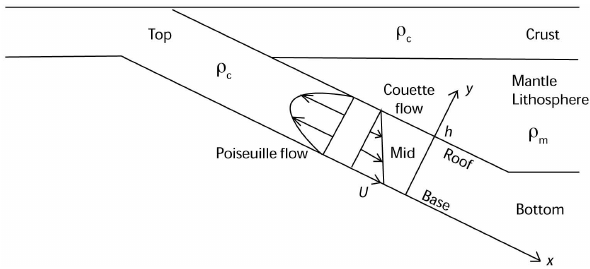
Fig. 3. Schematic diagram showing the nomenclature of subduc- tion/exhumation channel flow behaviour in terms of dominating Couette (subduction) and Poiseuille (exhumation) flows. Figure modified from Warren et al.